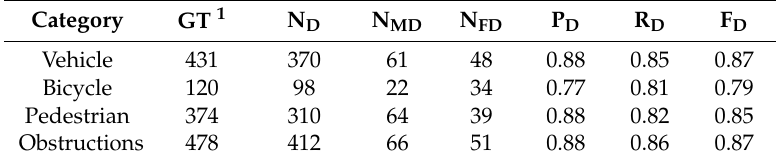
Table 3. Experimental evaluation of the obstacle detection module using computer vision techniques.